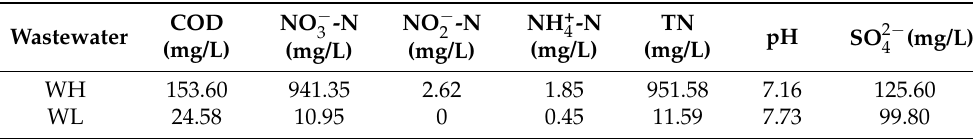
Table 1. Influent composition of the two experimental wastewater.